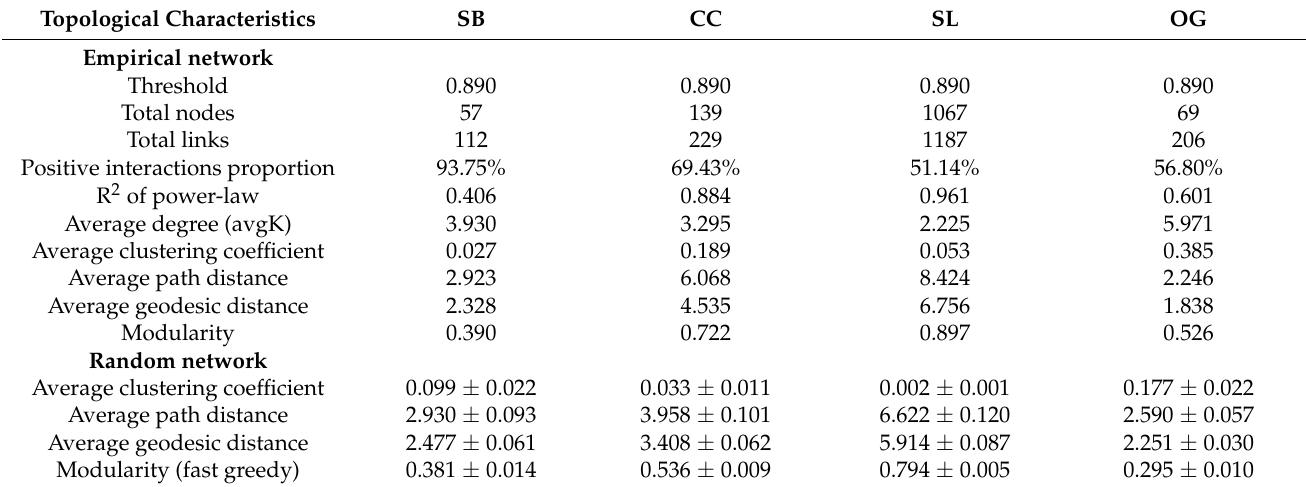
Table 1. Soil bacterial–fungal topological characteristics in the four forest stands.